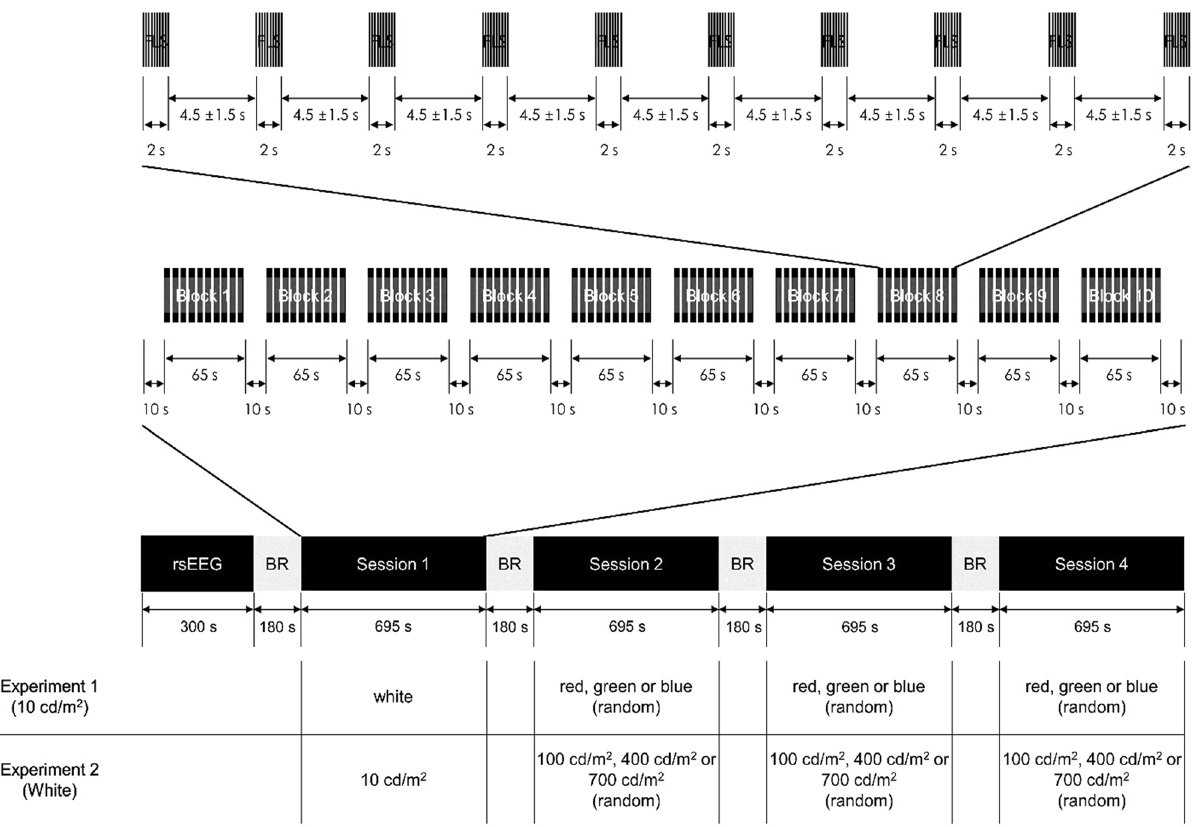
Figure 5. Experimental procedures. FLS flickering light stimulus; rsEEG resting-state electroencephalogram; BR